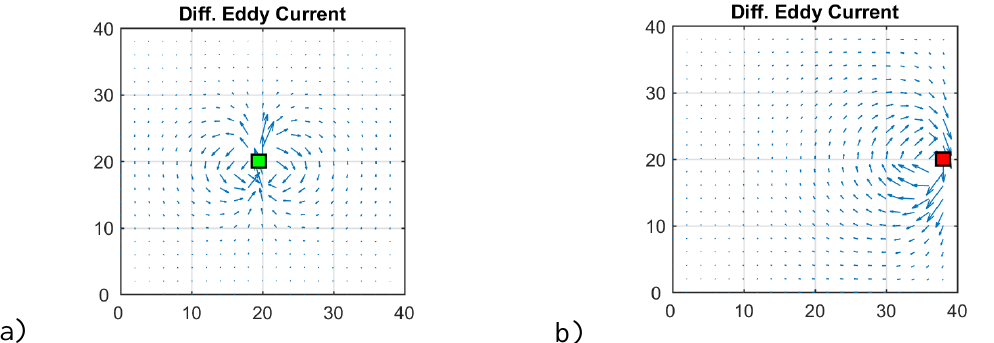
Figure 6. Differential eddy current density fields between a sheet with and without a void at the considered position. ( a ) A void in the middle; ( b ) a void at the edge.